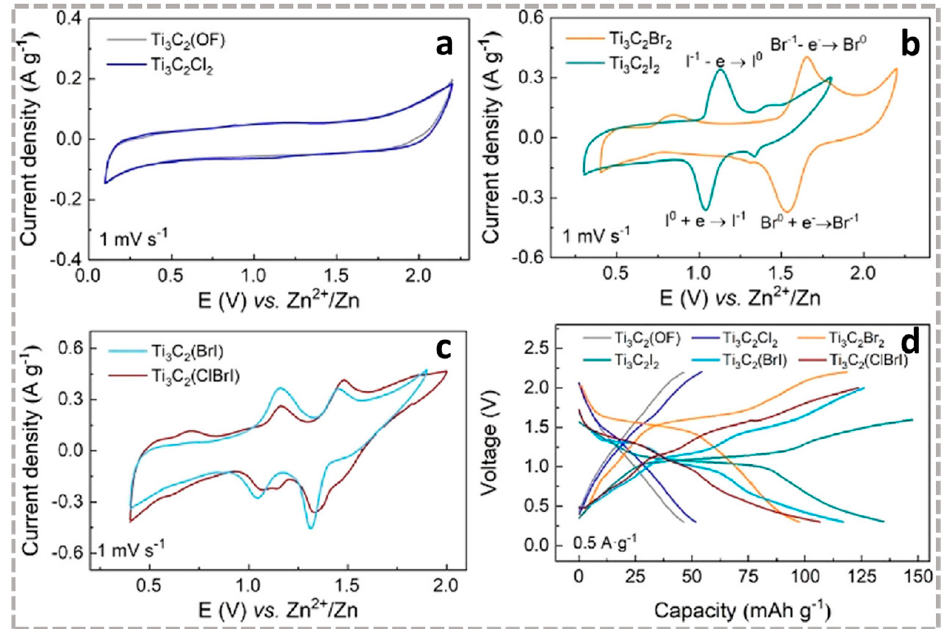
Figure 12. Cyclic voltammetry curve (CV) of ( a ) Ti 3 C 2 (OF), Ti 3 C 2 Cl 2 , ( b ) Ti 3 C 2 Br 2 , Ti 3 C 2 I 2 , ( c ) Ti 3 C 2 (BrI), and Ti 3 C 2 (ClBrI) at 1 mV s − 1 . ( d ) GCD curves of Ti 3 C 2 T x with terminals corresponding to ( a – c ) at 0.5 A g –1 [172]. ( a – d ) Reproduced with permission from ACS Nano. Table 4. Applications of MXene and MXene-based composites in ZIBs.